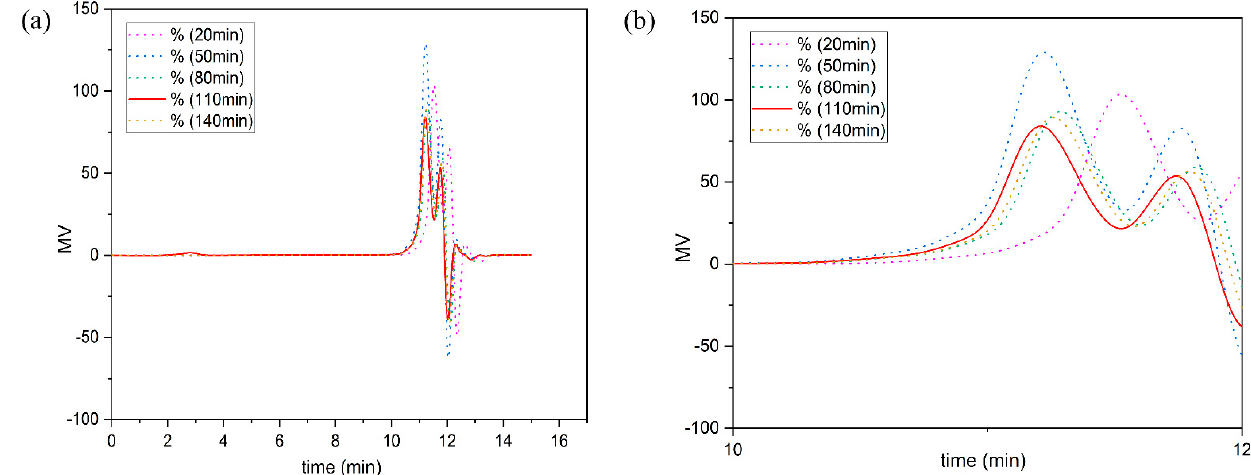
Figure 9. ( a ) GPC spectra of liquefied products at different liquefaction times. ( b ) Local enlarged view of GPC spectra of liquefied products at different liquefaction times.